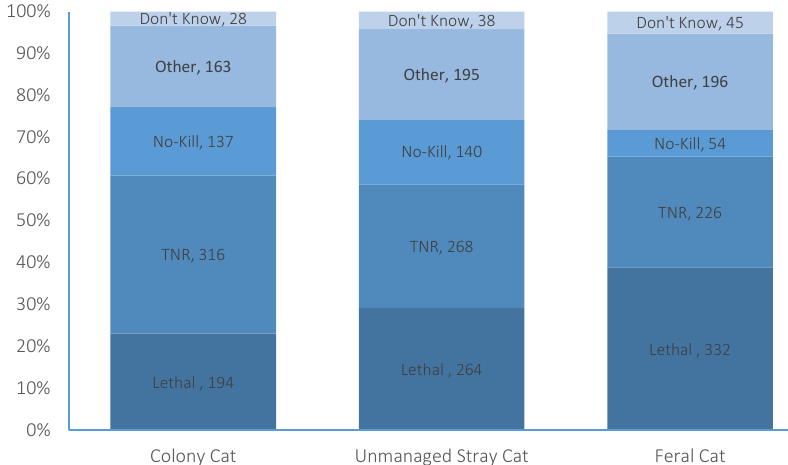
Figure 5. Participant opinion on the action that should be taken to control each subgroup of un-owned